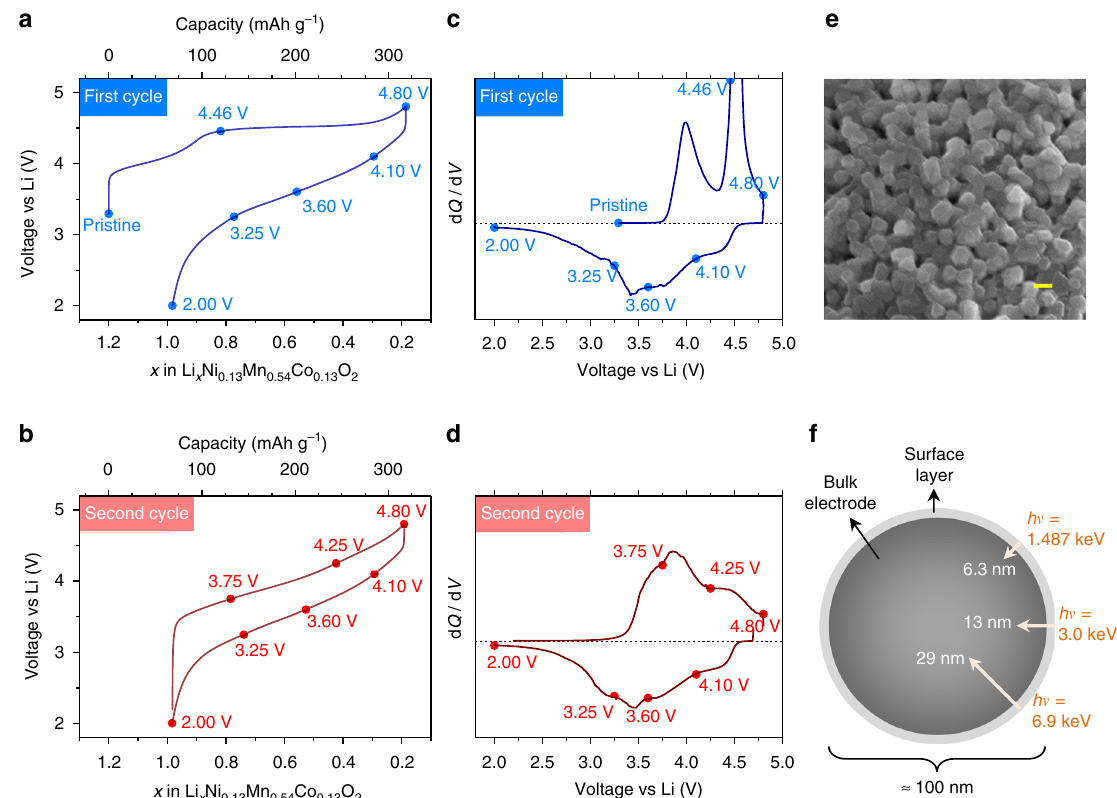
Fig. 1 Electrochemical curves with sample positions and HAXPES probe depths. Voltage pro fi les of Li 1.2 Ni 0.13 Mn 0.54 Co 0.13 O 2 (LR-NMC) in Li half-cells as a function of Li content with corresponding d Q /d V curves for the fi rst a , c and second b , d cycles. Current density is 20 mA g − 1 . Circles mark the sample positions on the curves. e Scanning electron microscopy (SEM) image (scale bar = 100 nm) of the pristine material showing the primary particle size. f Schematic view of XPS probe depths estimated for the O 1 s core peak at increasing photon energies from h υ = 1.487 to 3.0 and 6.9 keV. Higher energy photons allow for probing much beyond the surface layer to provide bulk information from the ~100 nm-sized primary particles. The probe depths are de fi ned as three times the photoelectron inelastic mean free path (IMFP) (estimated using the TPP-2M model 36 ) that corresponds to 95% of the signal coming from the sample. Note that the probe depths are related to the escape depth of photoelectrons and not to the penetration depth of photons, and that the photoelectron intensity exponentially decreases as a function of the distance from the